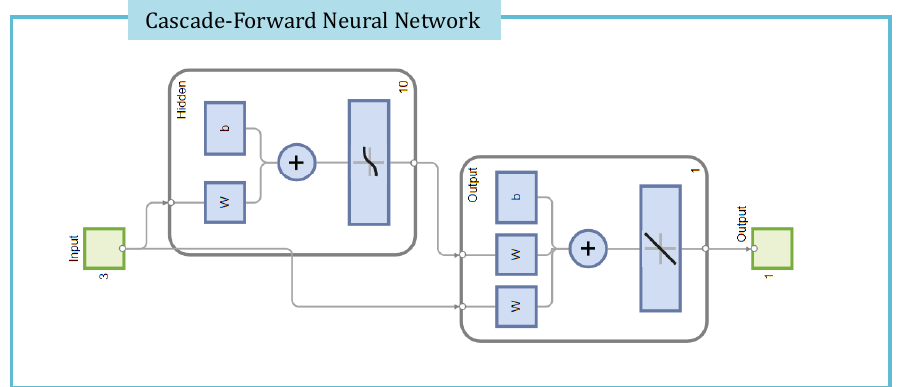
Figure 3. The cascade forward neural network with 10 hidden layer sizes, used as nonlinear estimator for the NLARX